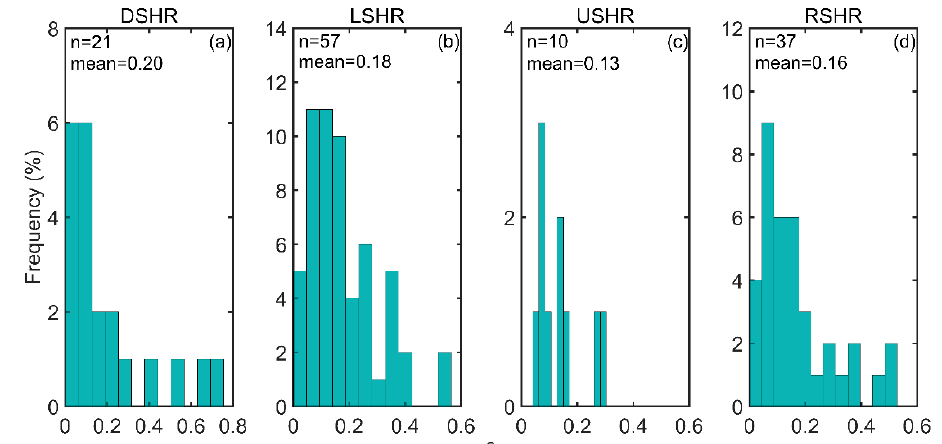
Figure 13. Histogram of the asymmetry parameter ( ε ) for: ( a ) Wind shear and storm motion directions are equal (DSHR); ( b ) wind shear is on the left side of the motion (LSHR); ( c ) wind shear and storm motion are in the opposite direction (USHR); and ( d ) wind shear is on the right side of the storm motion (RSHR). The number of storms in each group and the mean value of ε for each group are indicated.